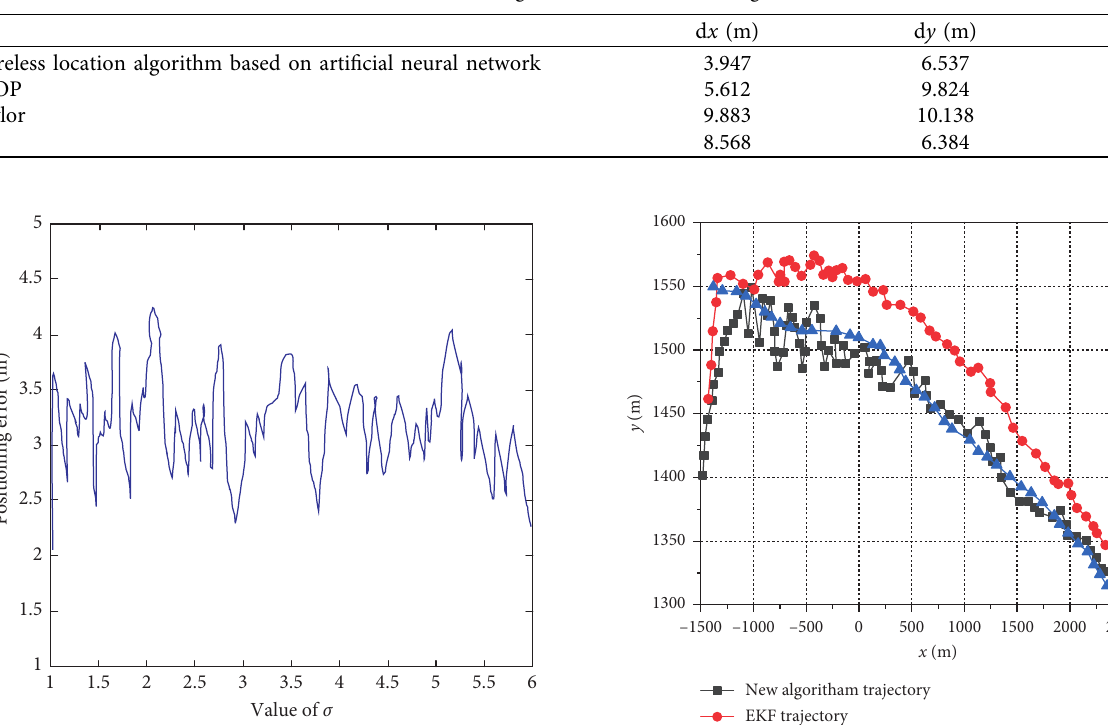
Figure 7: Relationship between value and positioning error.